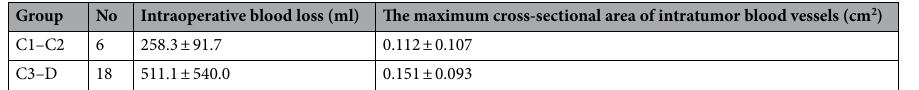
Table 4. The correlation among Fisch classification of tumor, intraoperative blood loss and the maximum cross-sectional area of intratumor blood vessels.